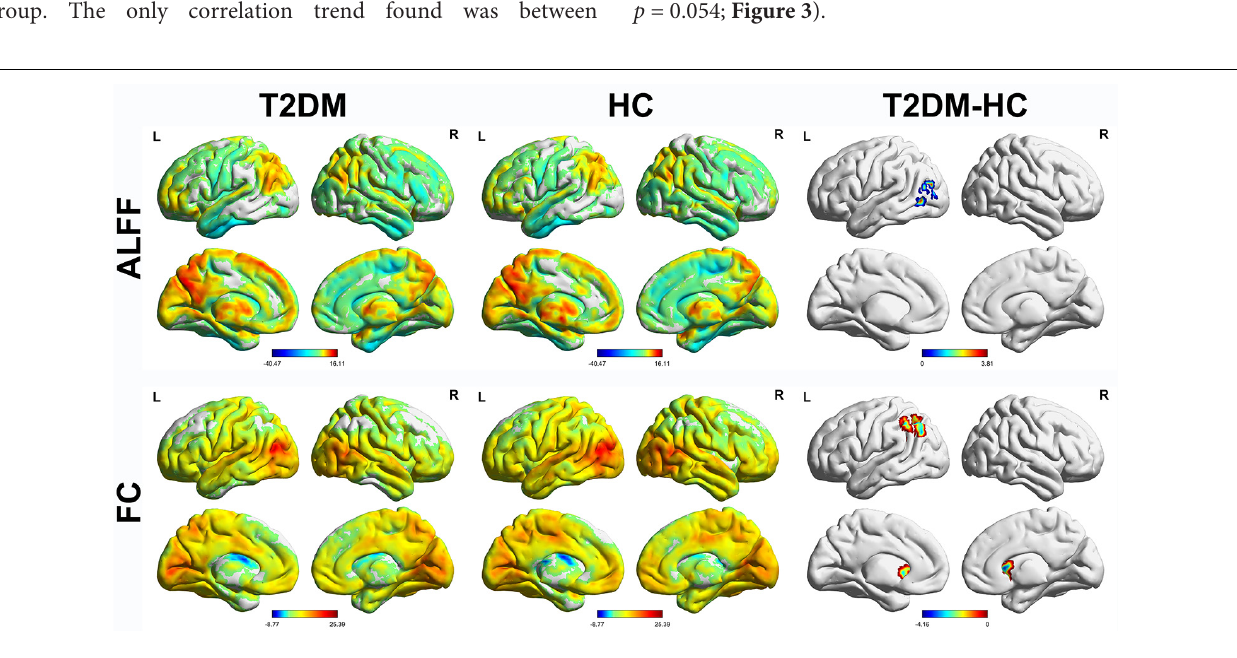
Frontiers in Aging Neuroscience |